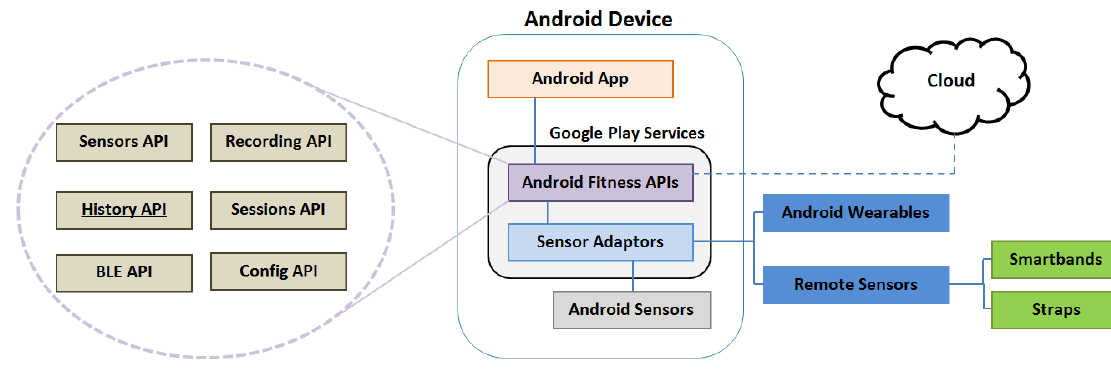
Figure 4. Google